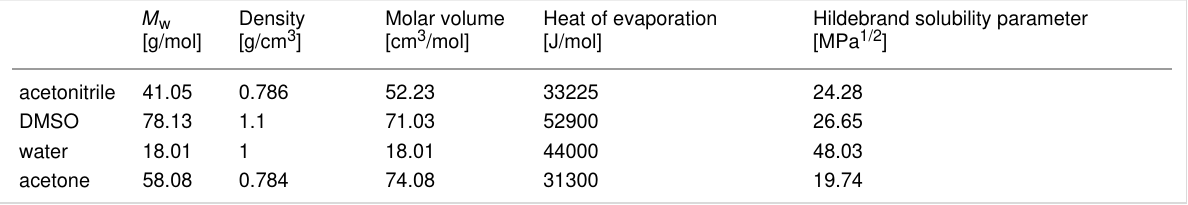
Table 1: Properties and miscibility of organic solvents with water according to the Hildebrand solubility